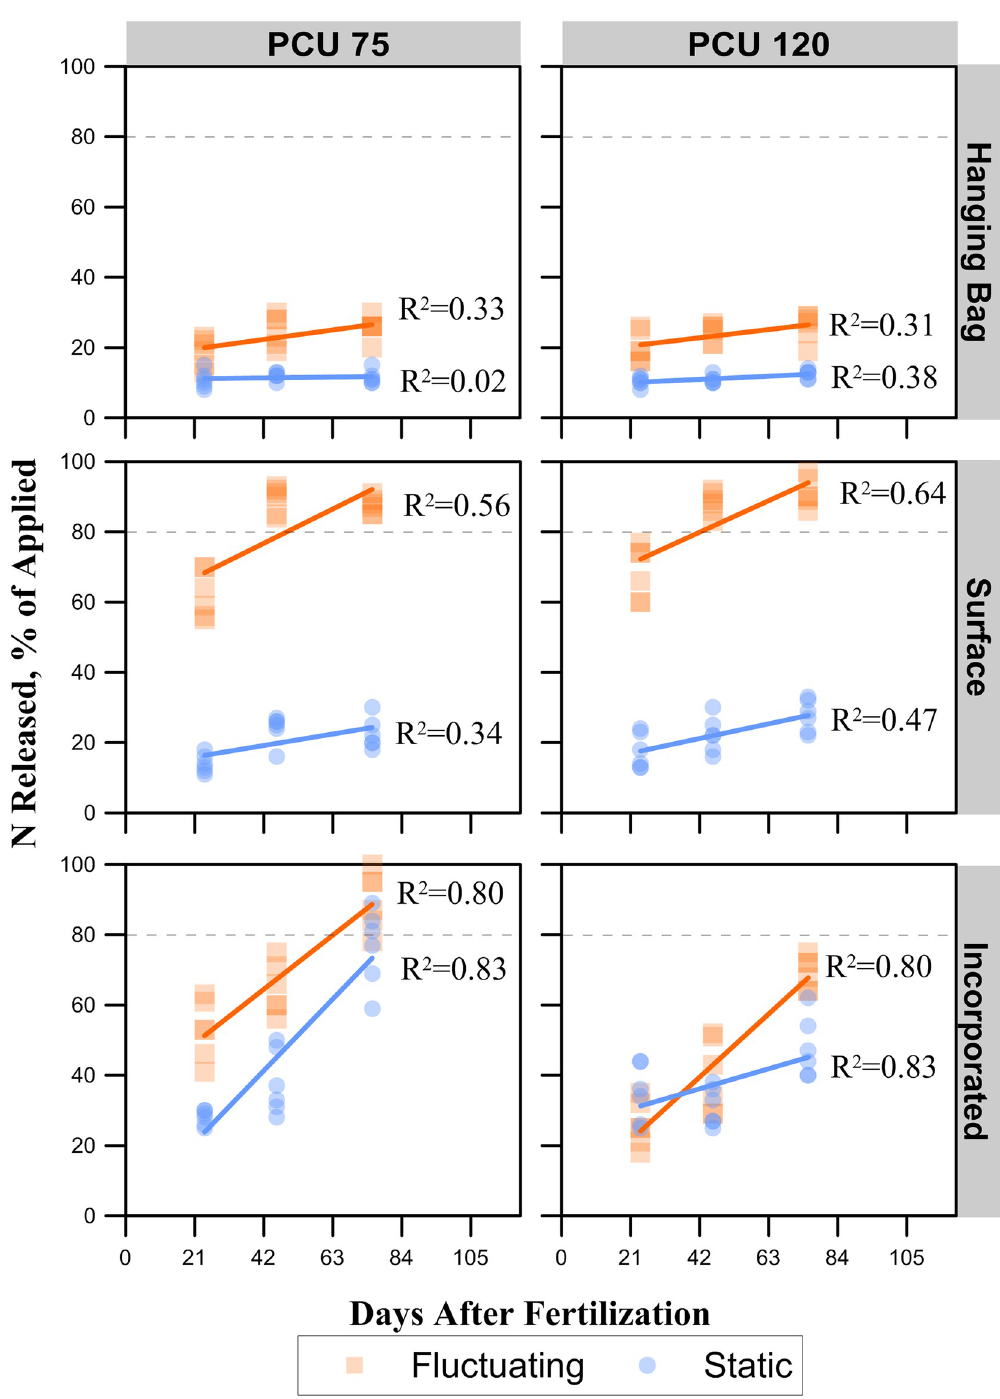
Fig 4. Experiment 2 N release rates for two fertilizer sources. (PCU) polymer-coated urea products with targeted release timings of 75 and 120 days applied either to the soil layer surface, incorporated into the soil, or in a hanging bag at either static or fluctuating daily temperatures. The dashed vertical line indicates the targeted cumulative release